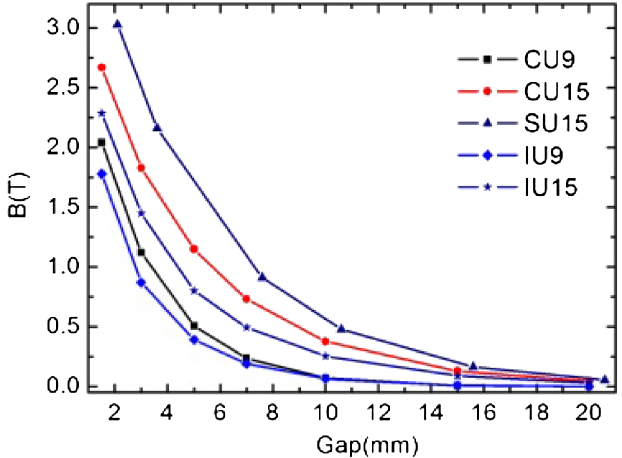
FIG. 2. Maximum magnetic-flux density in magnet gaps of various undulators with a short period length.